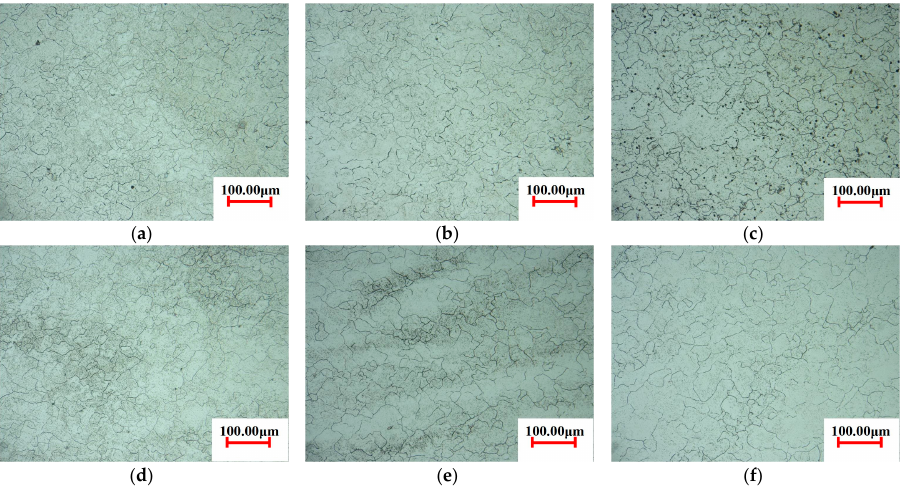
Figure 4. Microstructure of sample B at the interruption strain of 0.511 and different holding times: ( a ) 0 s; ( b ) 3 s; ( c ) 5 s; ( d ) 8 s; ( e ) 20 s; ( f ) 50 s.